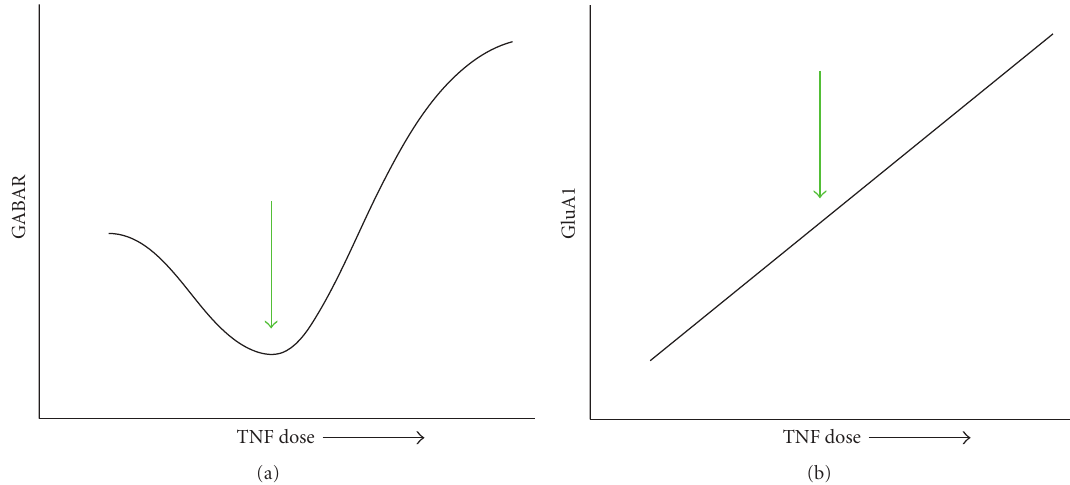
Figure 7: Graphical representation of combined findings from current research, Ferguson et al., 2008 [13], and Stellwagen et al., 2005 [10]. (a) Depiction of current findings that TNF causes a U-shaped response in total GABA A R in vivo . (b) Representation of findings from Ferguson et al. [13] that TNF causes an increase in total GluA1 in vivo . Green arrows represent the findings of Stellwagen et al., 2005 [10] that a particular dose of TNF elicits an increase in GluA1 and a decrease in GABA A R in vitro